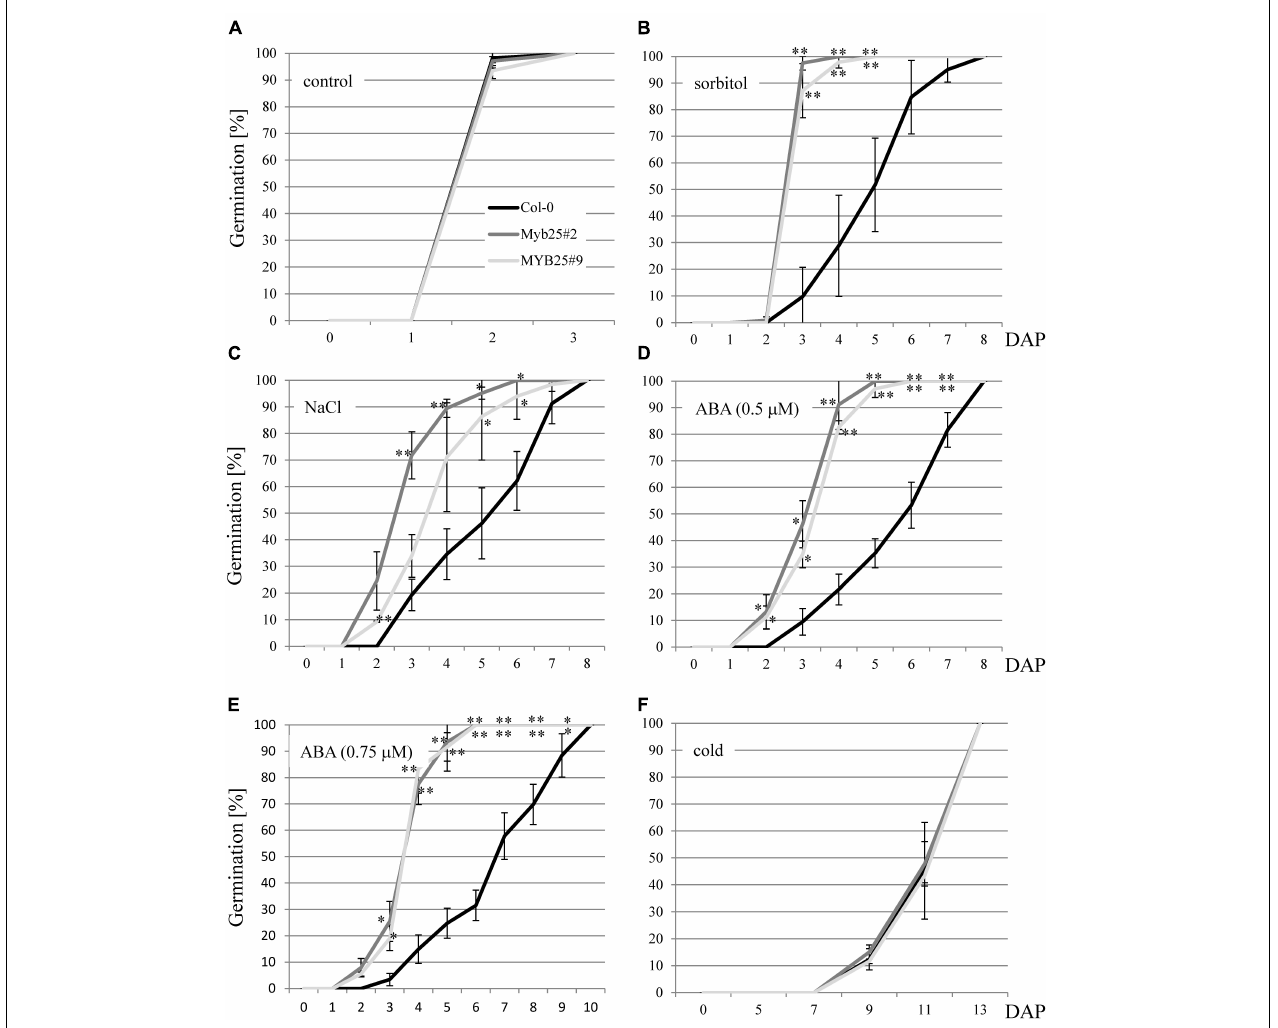
FIGURE 6 | Germination of MYB25:GFP seeds in the presence of abiotic stress and ABA. (A) Seeds of Col-0 and two independent transgenic MYB25:GFP plants (MYB25 #2 and #9) germinate at the same rate in the absence of stress. In the presence of either 300 mM sorbitol (B) , 150 mM NaCl (C) , or ABA (D,E) MYB25:GFP seeds germinated significantly faster than Col-0 wild type seeds. (F) No difference between transgenic and Col-0 seeds were observed when incubated in the cold (4 ◦ C). In all cases at least n = 30 seeds were analyzed per biological replicate. DAP, days after plating. In this and subsequent figures: ∗ , p < 0.05; ∗∗ , p < 0.01 (student’s t -test). Error bars show standard